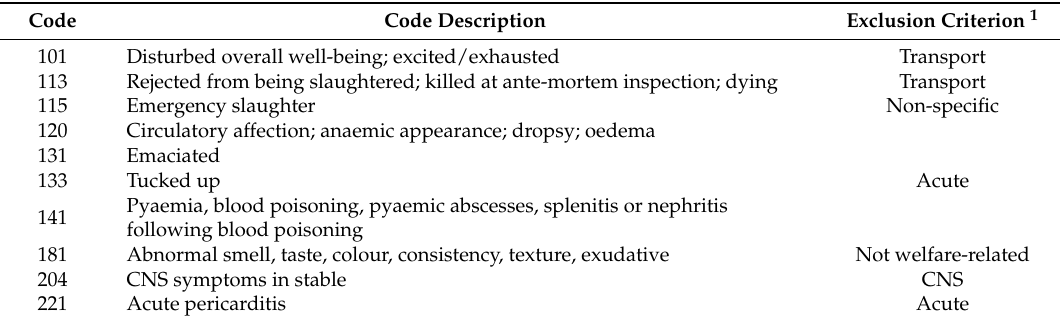
Table A2. Descriptions of cattle meat inspection codes (translated from Ministerial circular 9611 [8]) including exclusion criterion for excluded